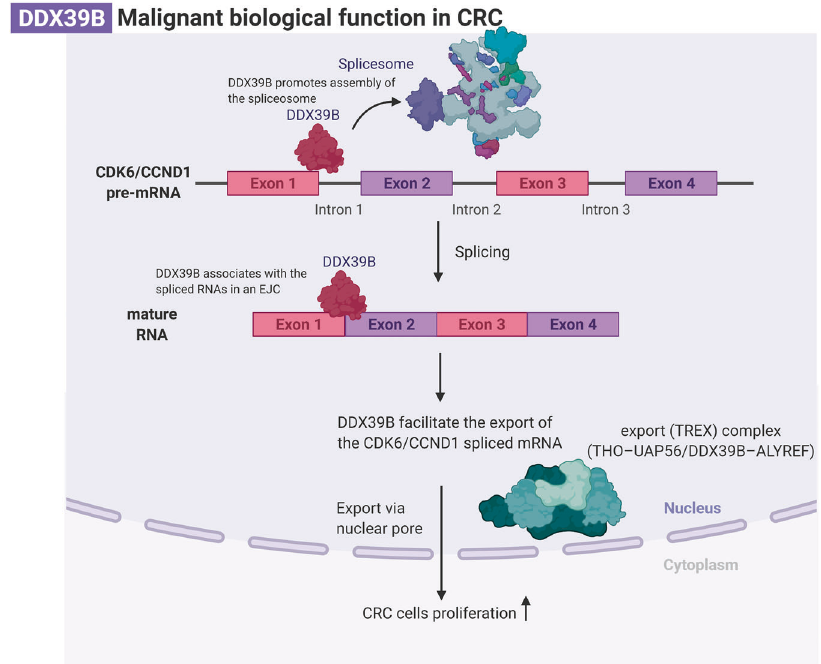
Fig. 6 Hypothesized molecular mechanism of DDX39B in proliferation of CRC. This molecular mechanism fi gure is created with BioRender.